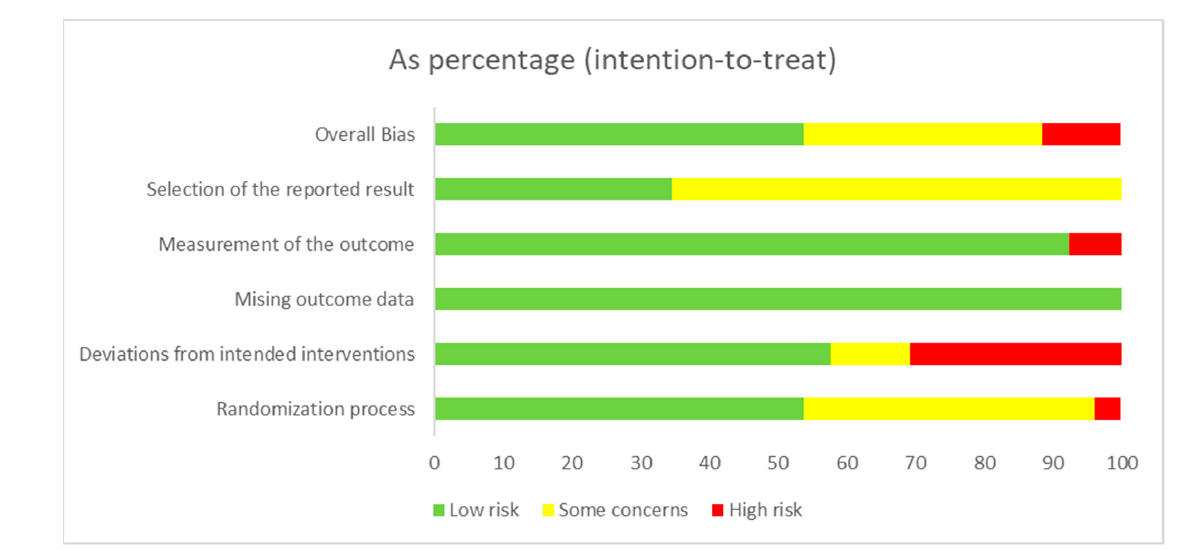
Figure 3. Risk of bias graph: review authors’ judgments about each risk of bias item presented as percentages across all included studies.